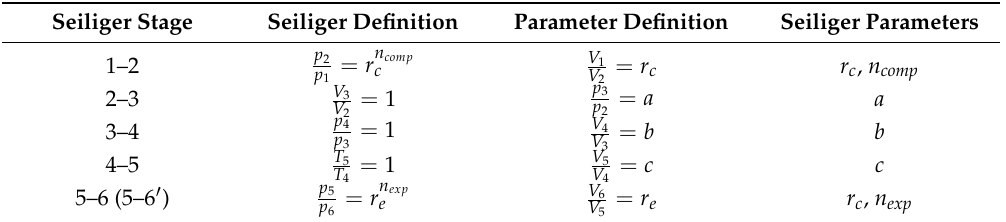
Table 2. Seiliger process definition and parameters.